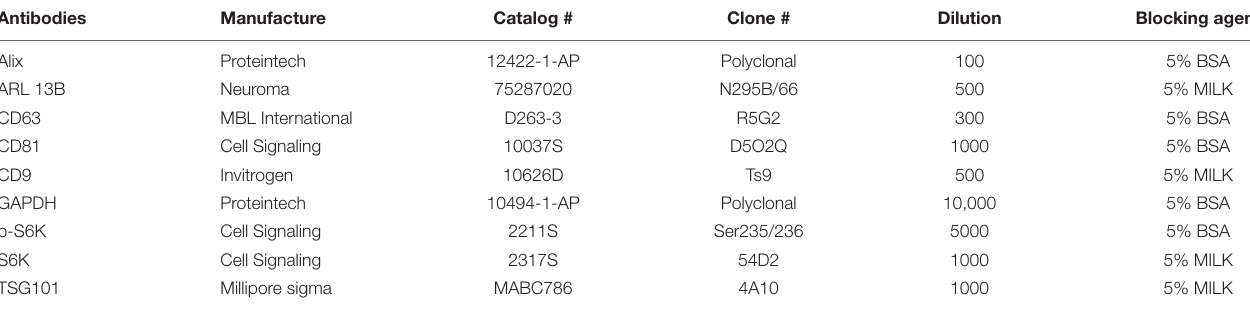
TABLE 1 | List of antibodies used in the